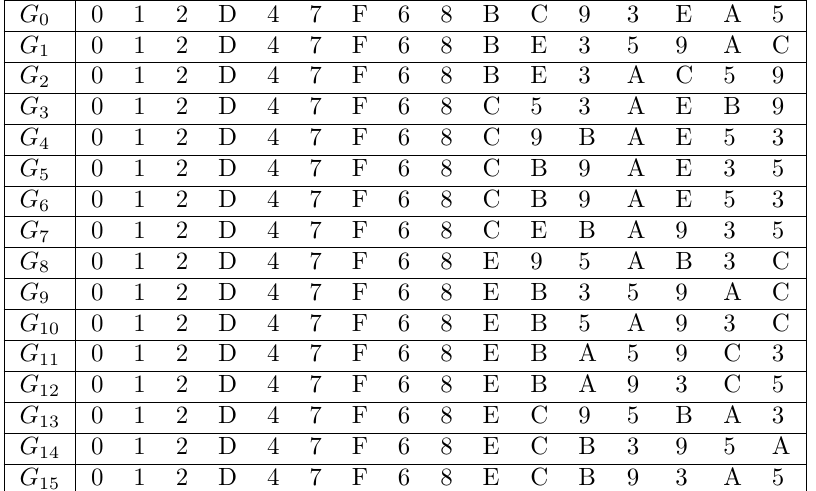
Table 11: Representatives for all 16 classes of optimal 4 bit S-boxes